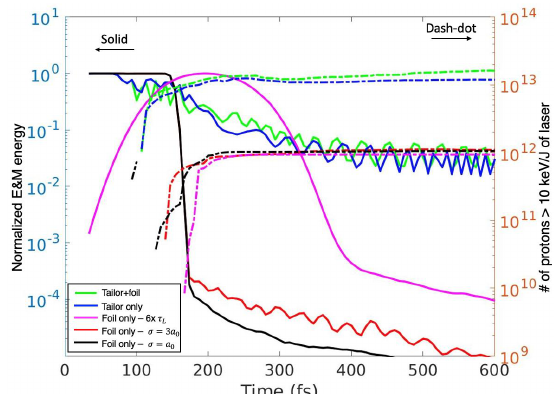
Figure 7. Normalized total electromagnetic energy in the computation domain (solid) and number of protons above 10 keV per input laser energy (dot-dash) vs. time. The case of tailor + foil (green) displays an elevated E&M energy for a long duration and subsequently high number of energetic protons. The case of 6 × longer pulse (magenta) produces the same number of energetic protons per laser